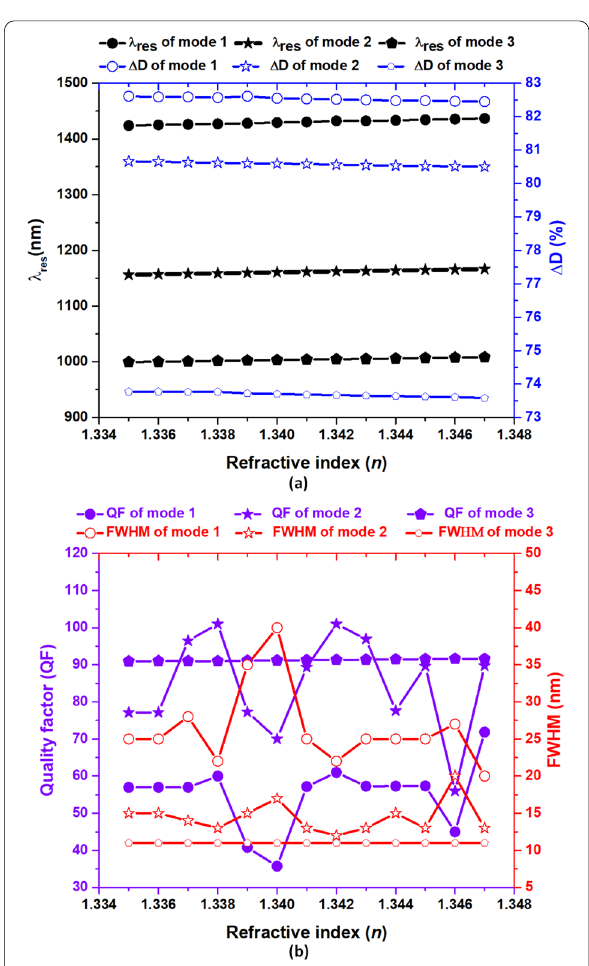
Fig. 8 a λ res and ∆D and b QF and FWHM versus the RI value ( n ) from 1.335 to 1.342 with the interval of 0.001 of case 3 structure for mode 1 to mode 3,